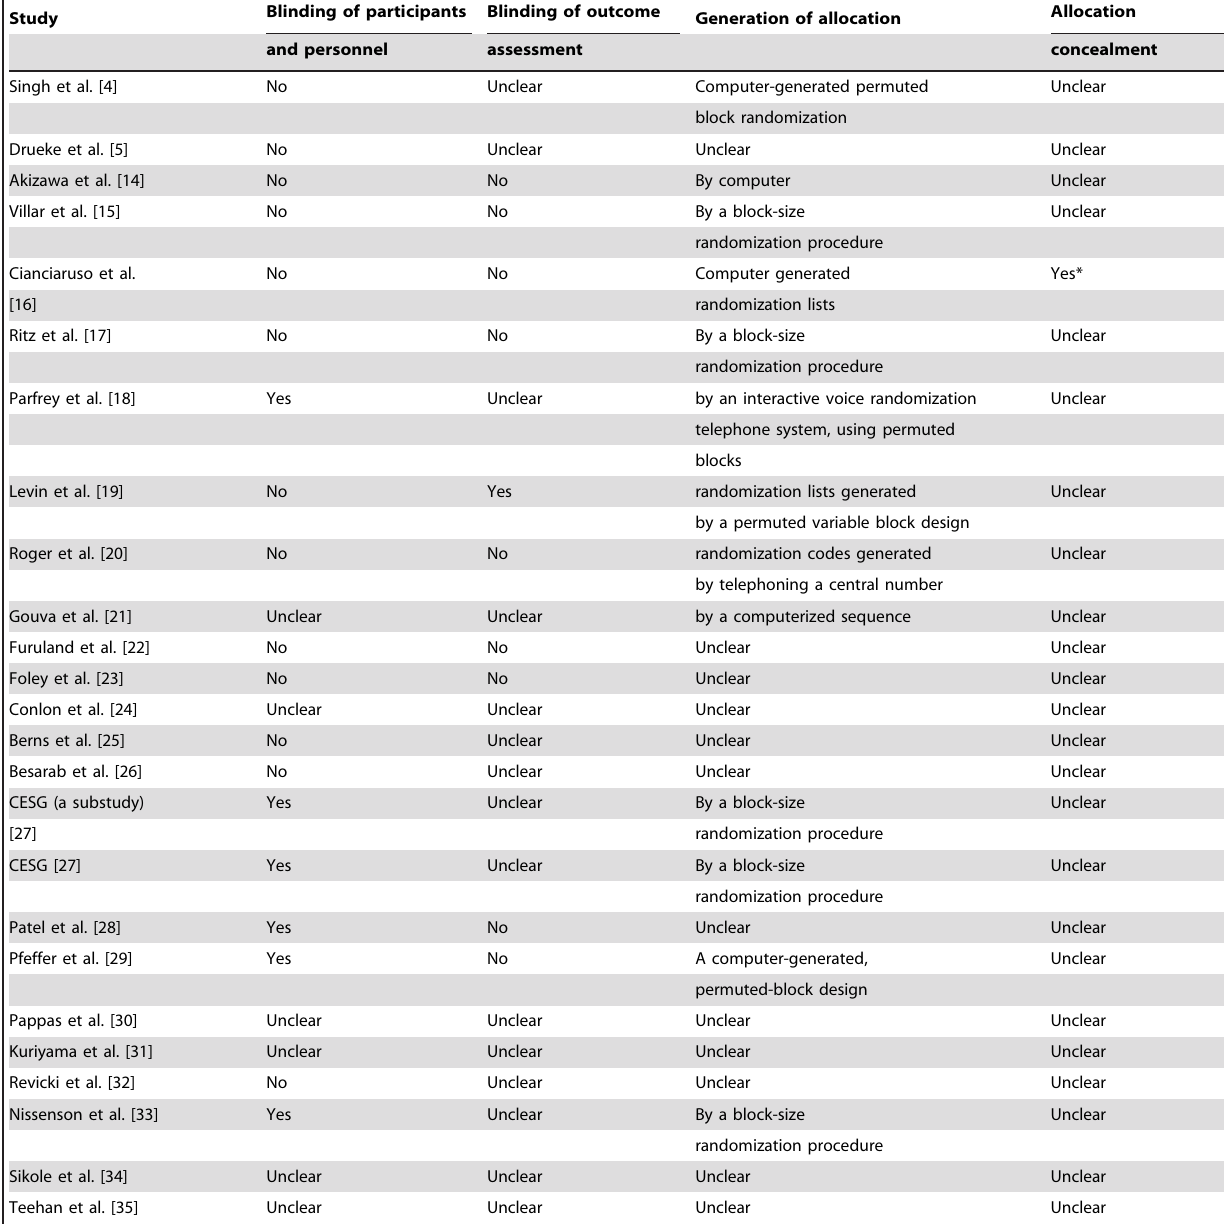
Table 2. Details on risk of bias